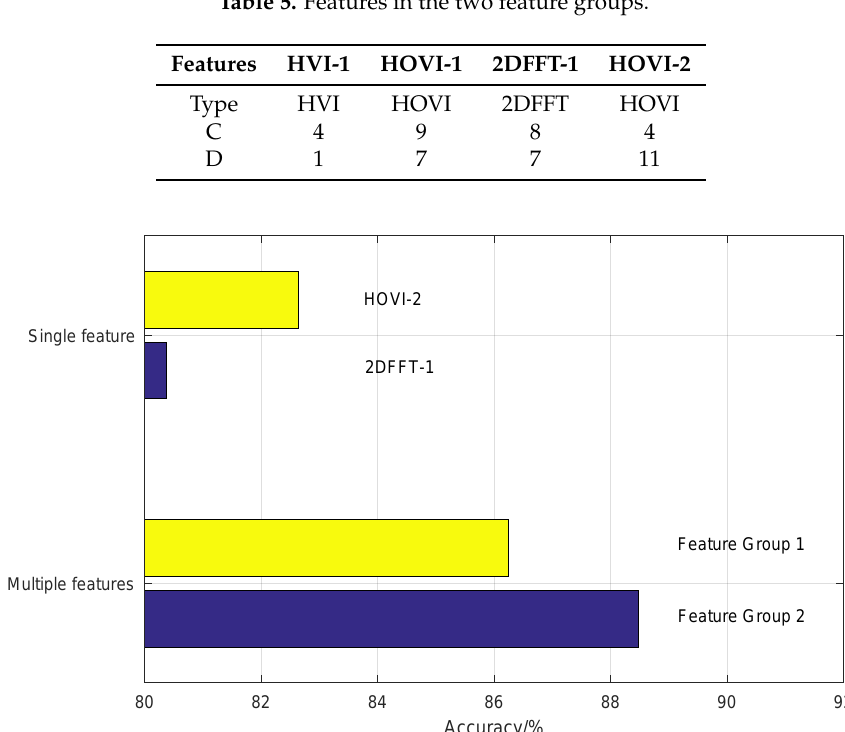
Table 5. Features in the two feature groups.